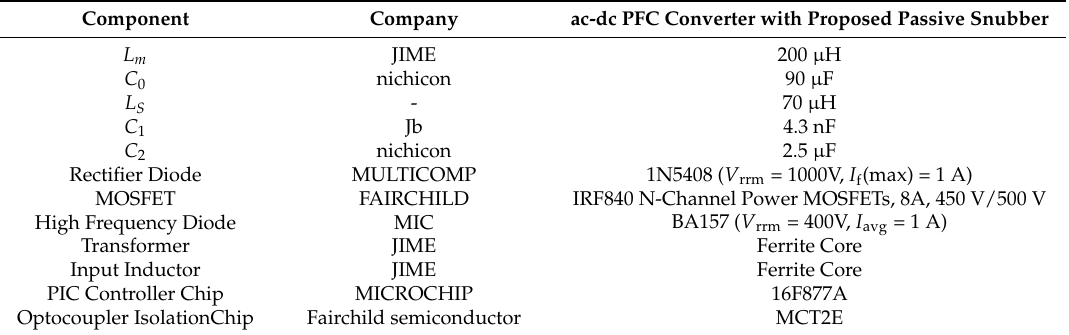
Table 1. Component values for the experimental ac ‐ dc PFC converter with proposed passive snubber. Component